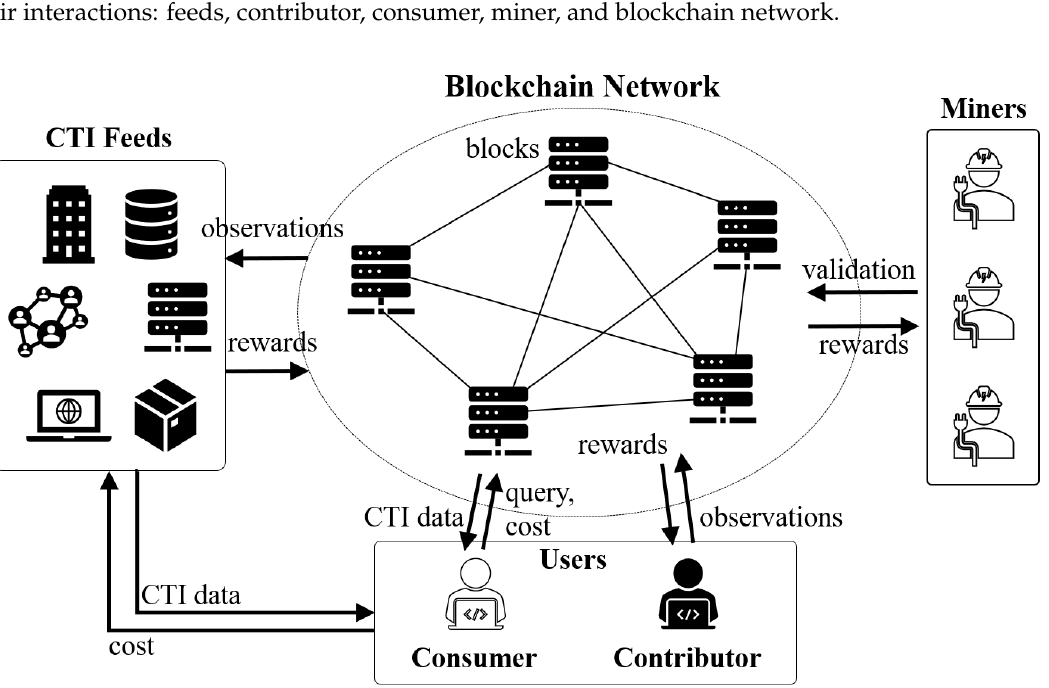
Figure 3. System model of blockchain-based cyber threat intelligence